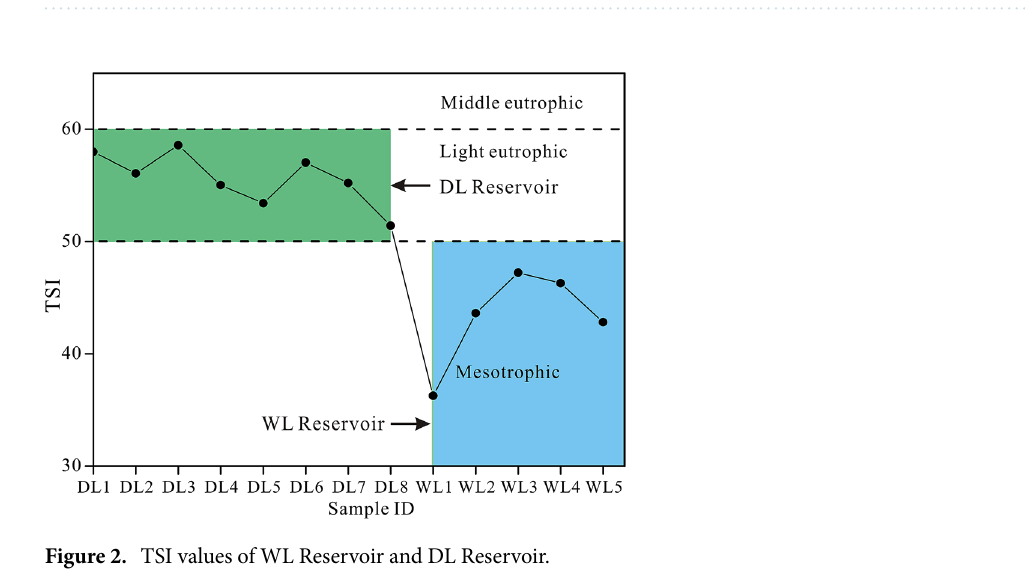
Table 1. Physical–chemical characteristics of water samples from WL Reservoirs and DL Reservoir.